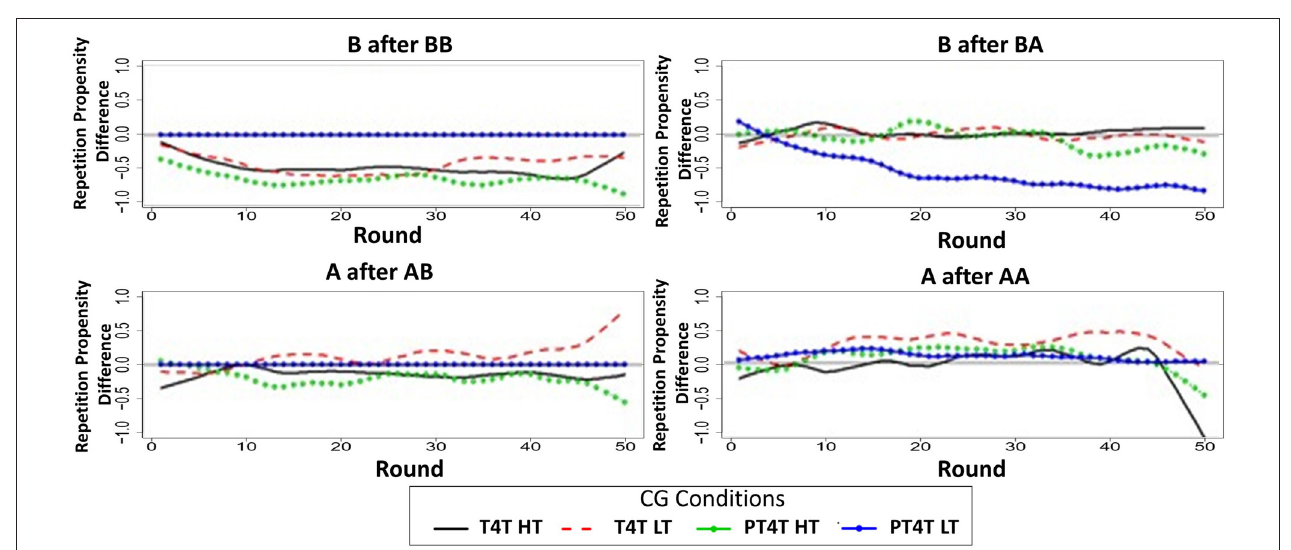
FIGURE 6 | The difference of the round-by-round repetition propensities between the model and participants for the four different repetition propensities during the Chicken Game (CG) in conditions when it was played first in the Tit-for-Tat (T4T) high trustworthiness (HT; solid black line), T4T low trustworthiness (LT; dashed red line), Pavlov-Tit-for-Tat (PT4T) HT (green line with sold dot), and PT4T LT condition (blue line with closed dot). All of the round-by-round repetition propensities were smoothed by using the loess function in R (smoothing parameter of 0.2), to remove some of the round-by-round